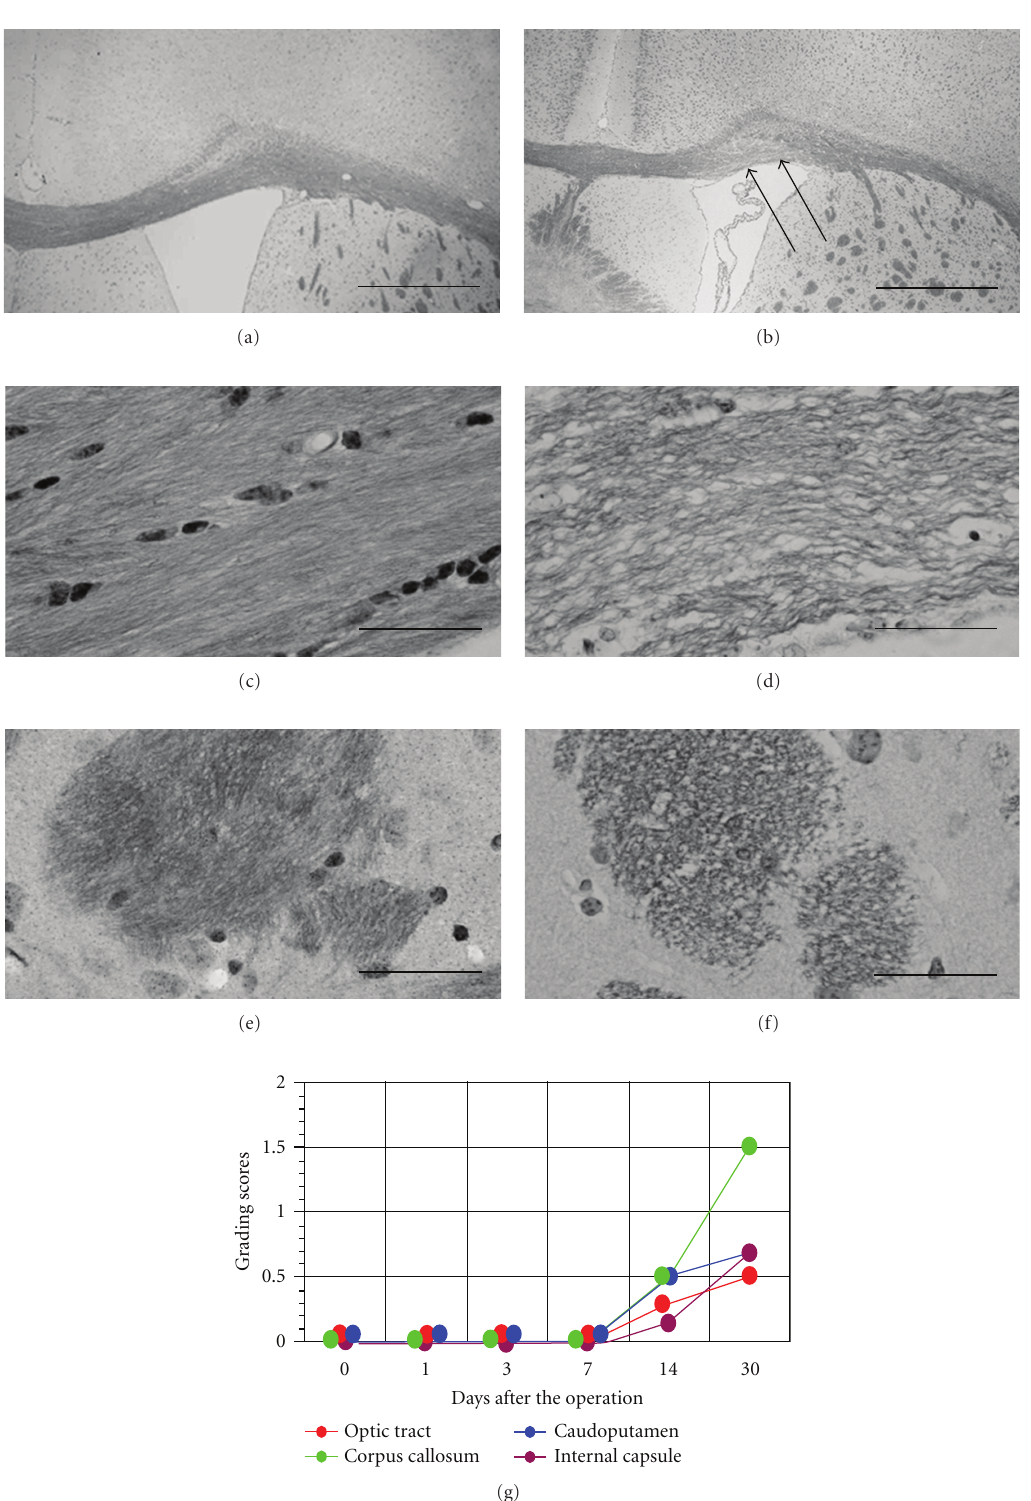
Figure 3: White matter changes after BCAS. Photomicrographs of Kl¨uver-Barrera staining in the cerebral cortex (a, b), corpus callosum (c, d), and caudoputamen (e, f). The left column (a, c, e) indicates the brain from a sham-operated mouse, and the right column (b, d, f) indicates a brain after BCAS-operated mouse using microcoils with 0.18 mm diameter for 30 days. Note that the WM changes are the most intense in the medial part of the corpus callosum adjacent to the lateral ventricle (arrows). The histogram shows temporal profiles of the WM changes, the severity of which is semiquantitatively graded into four levels (g). Scale bar, 500 μ m (a, b), 50 μ m (c, d), and 25 μ m (e,